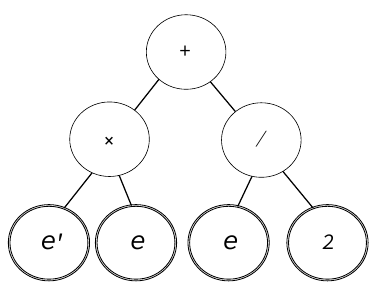
Figure 5. A parse tree, representing the sample SAF δ = e’ e + e /2.